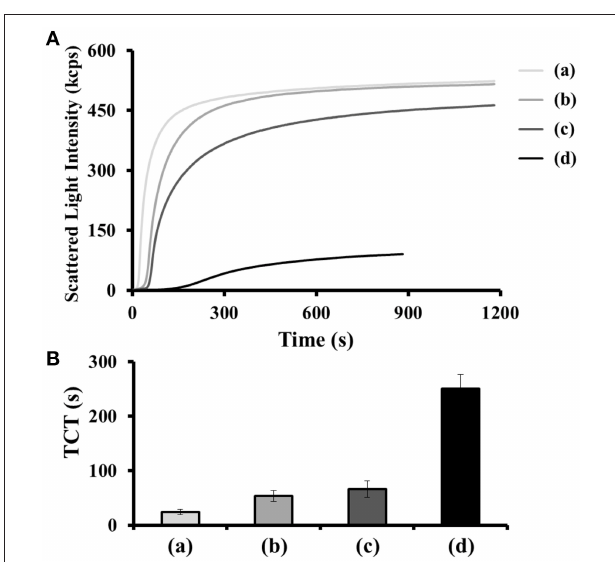
FIGURE 1 | (A) Scattering light intensity as a function of time for coagulating mixtures of thrombin (15nM), human plasma (2-fold diluted), BSA (100 µ M) in the (a) absence and (b–d) presence of (b) nh-TBA 15 / 29 , (c) di-TBA 15 / 29 , and (d) Supra-TBA 15 / 29 with a concentration of 100nM (in terms of TBA). (B) TCT obtained from the light scattering intensities generated by the coagulation process. The TCT for each sample was noted as the time at which the differential scattering signal intensity reached the maximum. The longest